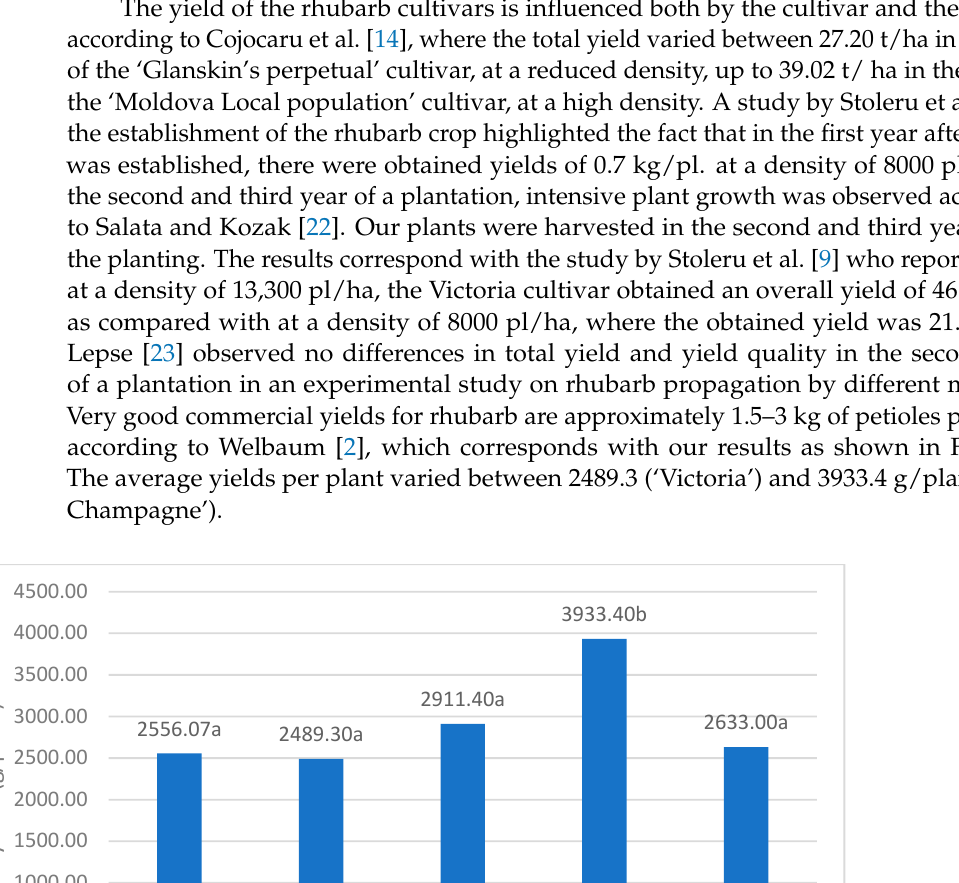
Figure 2. Average petiole yield for tested rhubarb cultivars. Values with different letters are significantly different at p < 0.05 by LSD test in ANOVA (Statgraphic XVII).